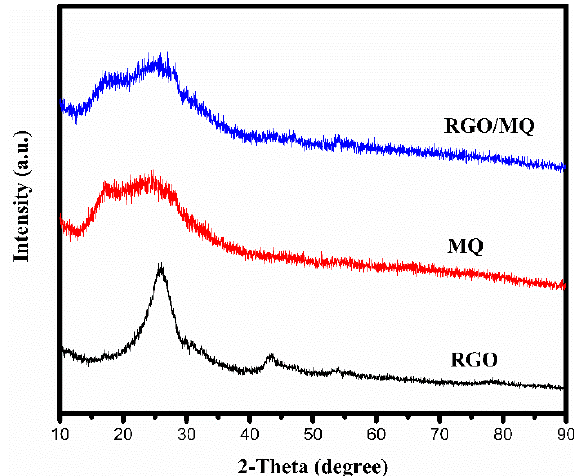
Figure 2. Scanning electron microscopy (SEM) images of ( a , b ) RGO, ( c , d ) MQ and ( e , f ) RGO/MQ at different magnifications.